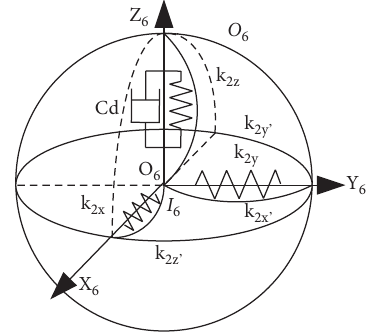
Figure 7: Spatial elastic damping